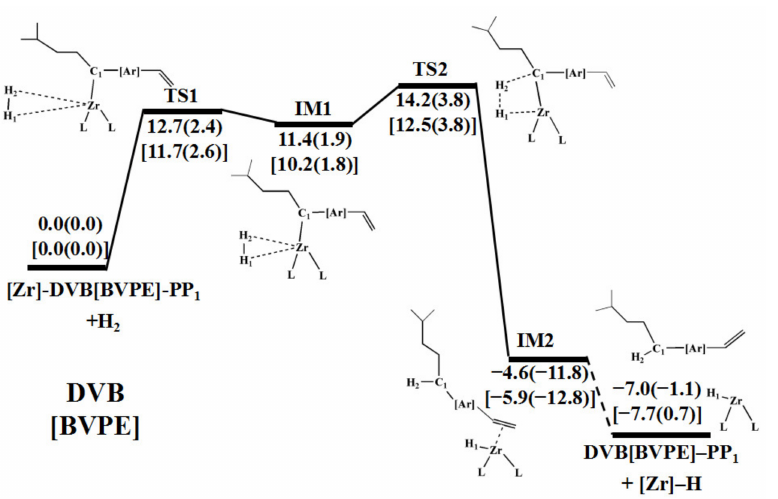
Figure 2. The relative free energy of the reaction pathway involving hydrogen is given in kcal/mol, and the relative energy of BVPE is given in brackets; the relative enthalpy is also given in parentheses for reference (in